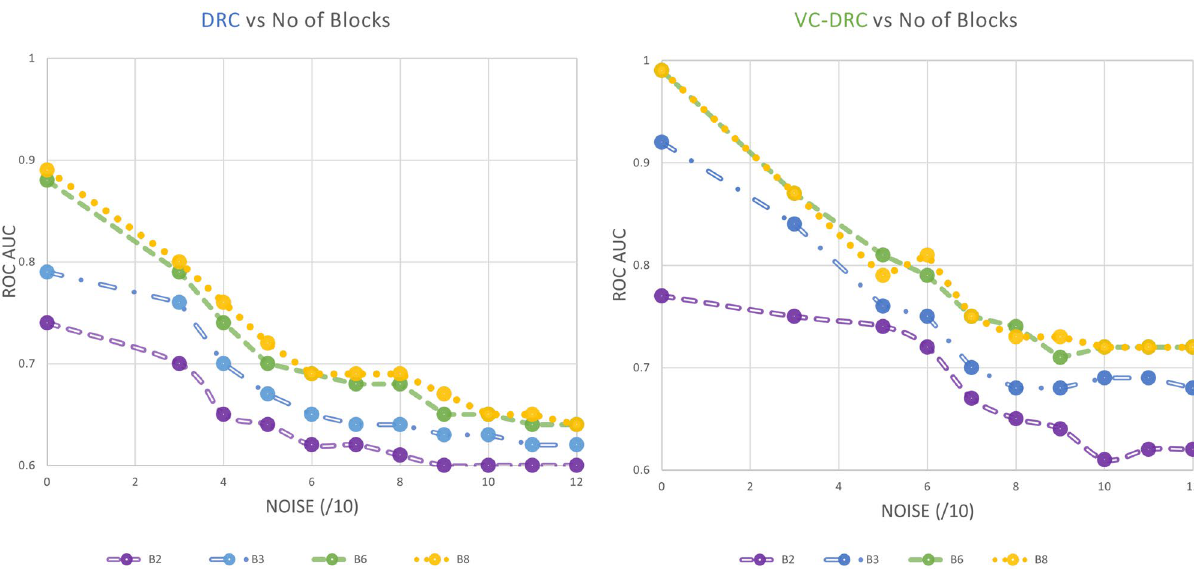
Figure 2. AUC–ROC as a function of number of repeating blocks of data re-uploading for the DRC classifier (left) and VC–DRC classifier